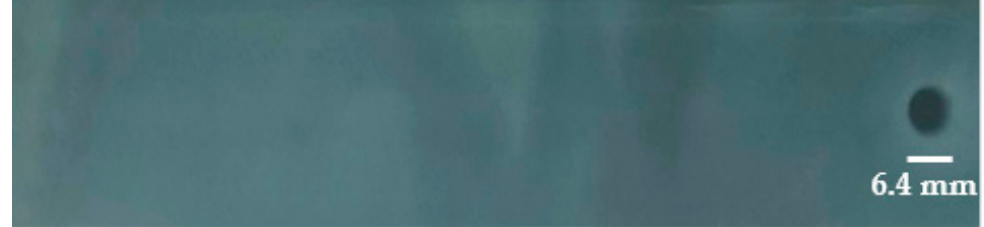
Figure 13. Tool 1 trial—X ‐ ray of an AA 6061 ‐ T6 aluminum FSW weld.